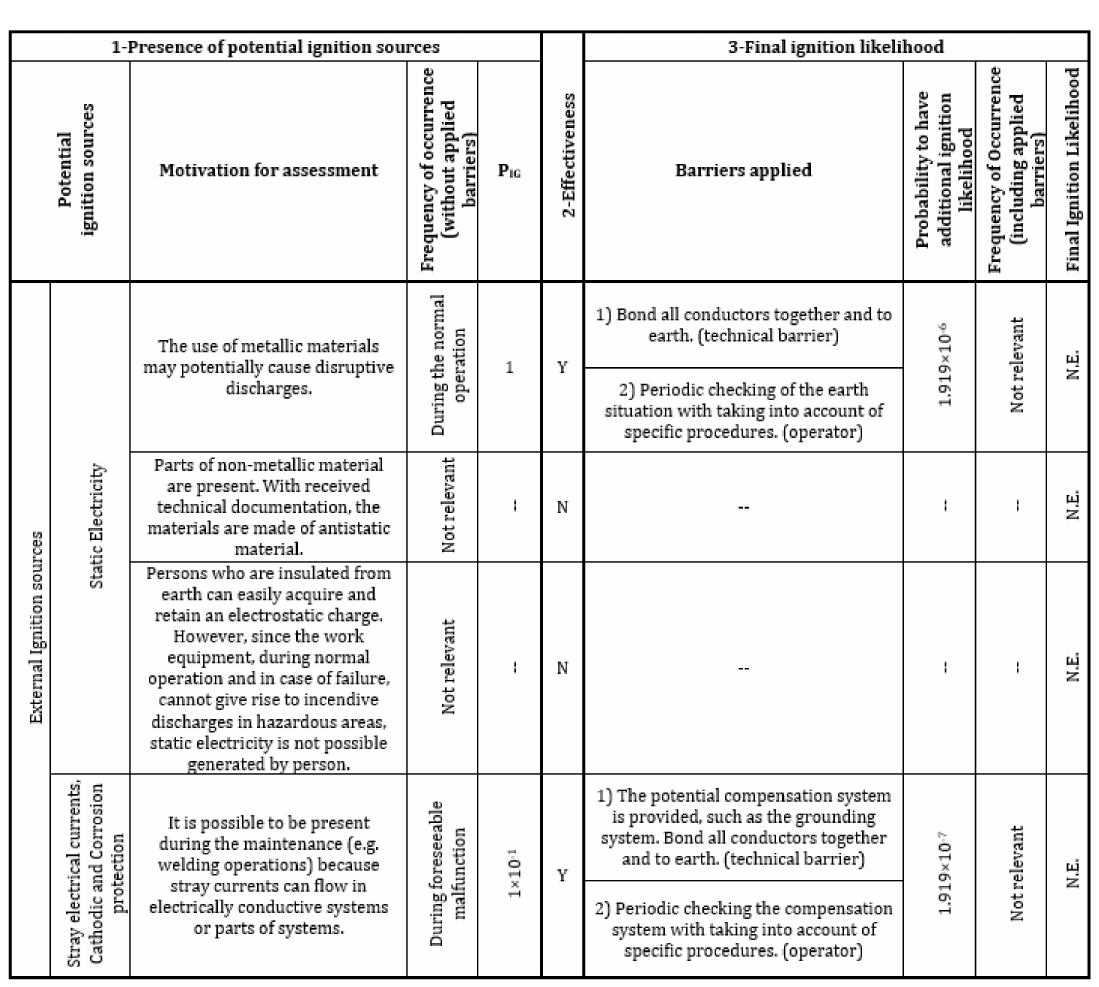
Figure A3. External ignition sources estimation within the ATEX-HOF methodology (part